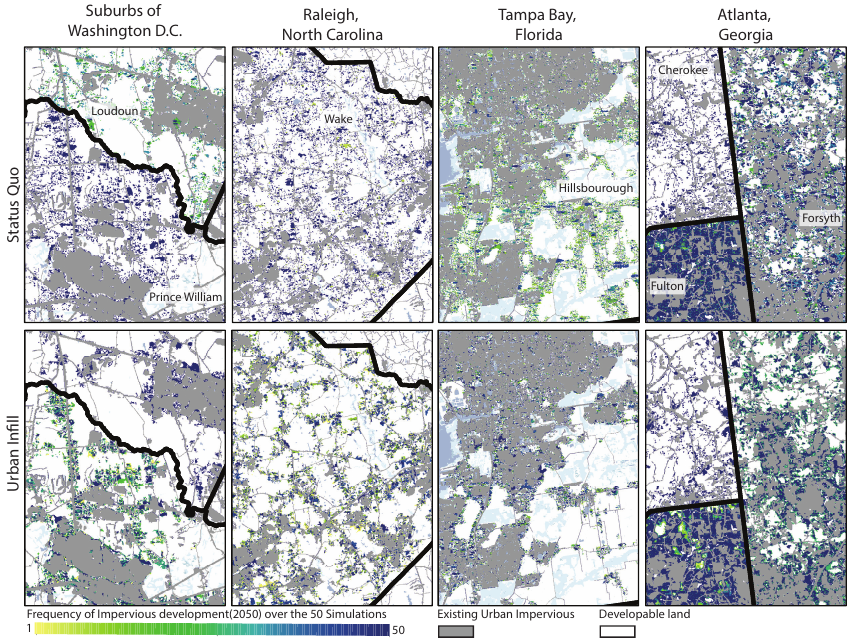
Figure 3. Frequency of urban development in four SAS subregions for 50 simulations based on Status Quo and Infill